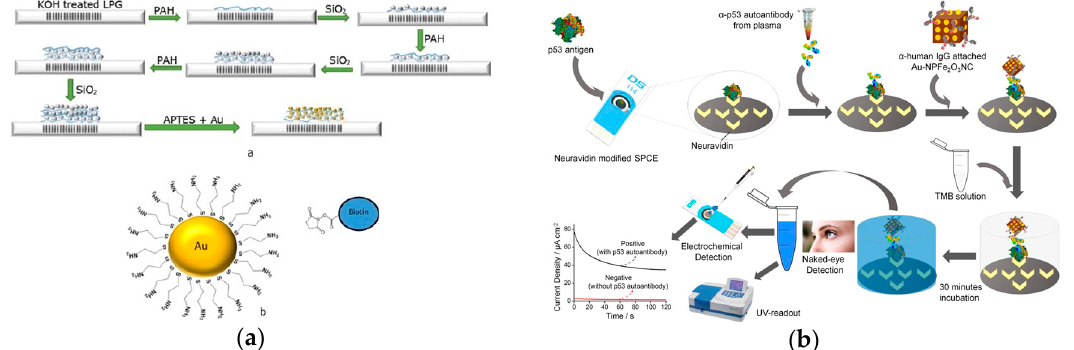
Figure 8. ( a ) Top: Illustration of the fabrication process for a long period grating (LPG) biosensor through the addition of three layers of poly-allylamine hydrochloride (PAH) and silica nanoparticles, functionalized with gold nanoparticles. Bottom: gold nanoparticle structure that can bind biotin. (Adapted from Ref. [62]. Copyright © 2018 Elsevier B.V.) ( b ) Illustration of antibody detection using Au-nanoparticles using optical and electrochemical methods. (Adapted with permission from Ref. [63]. Copyright 2017 American Chemical